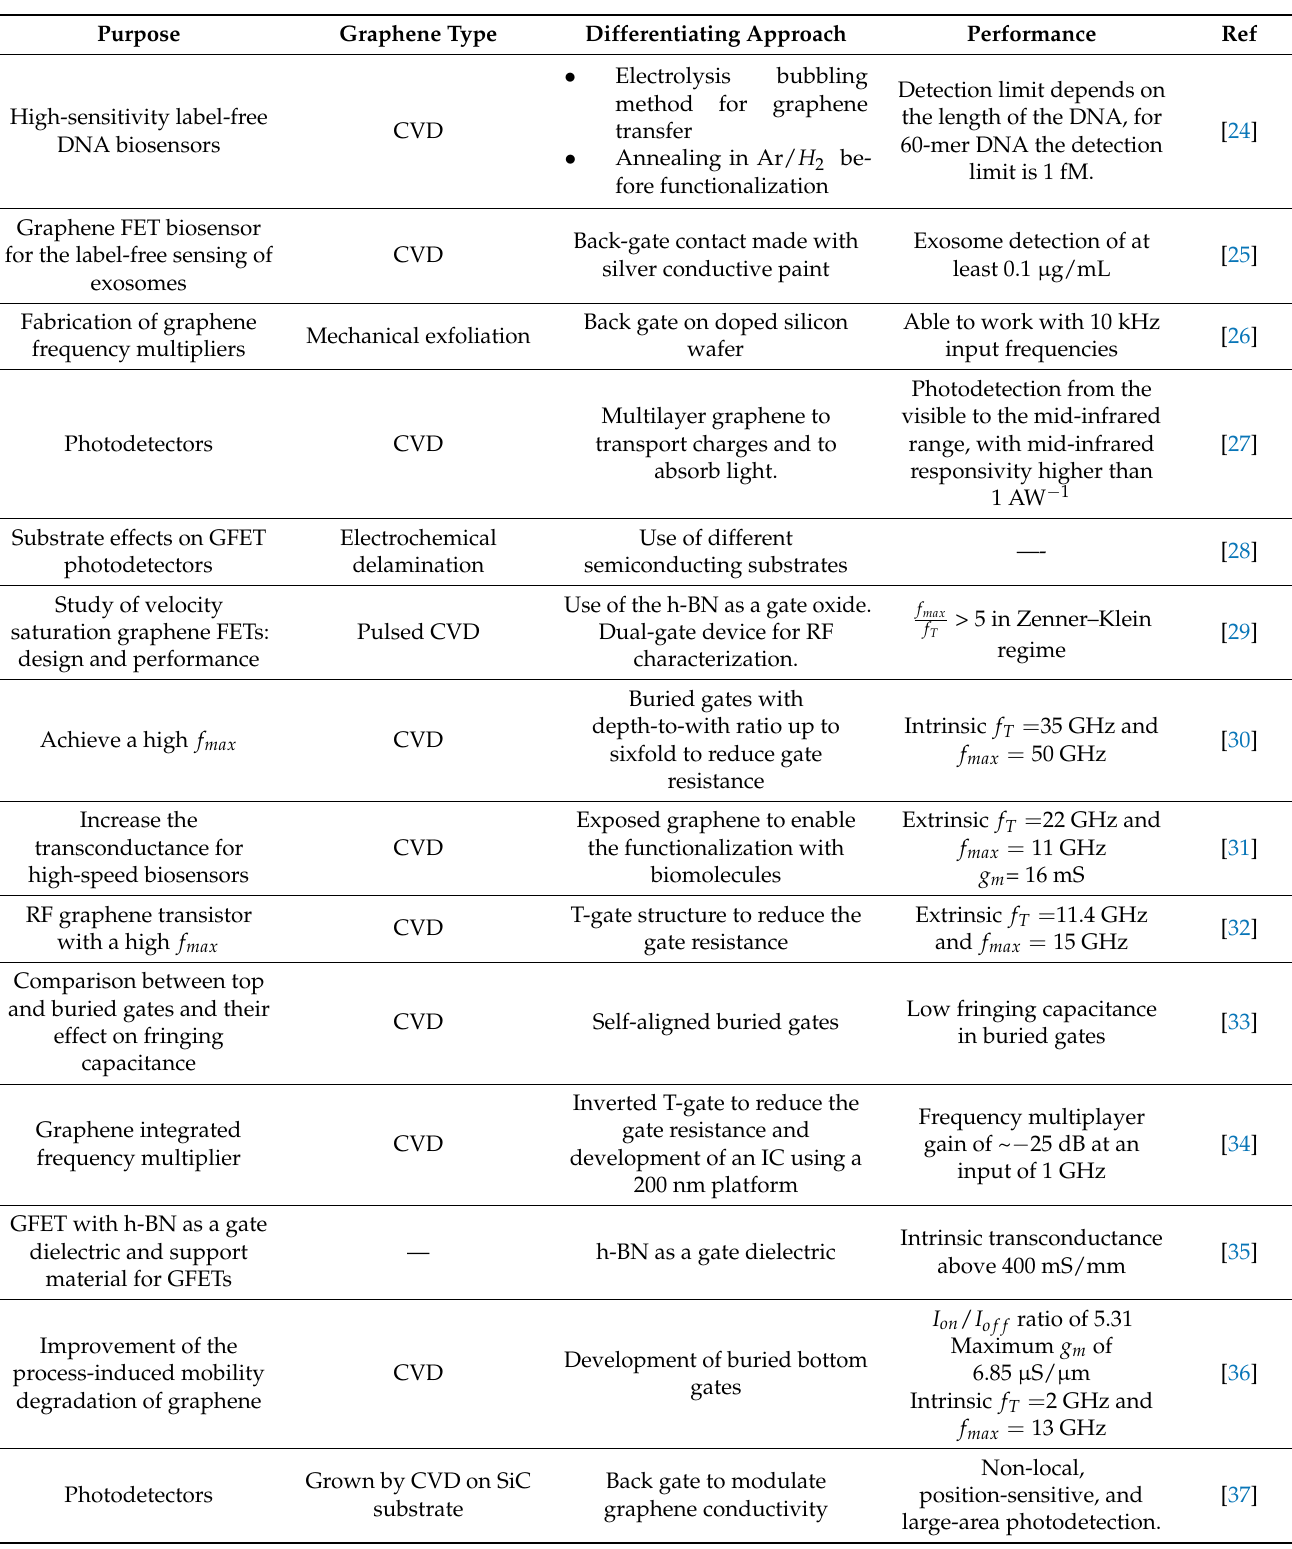
Table 2. Back-gated graphene